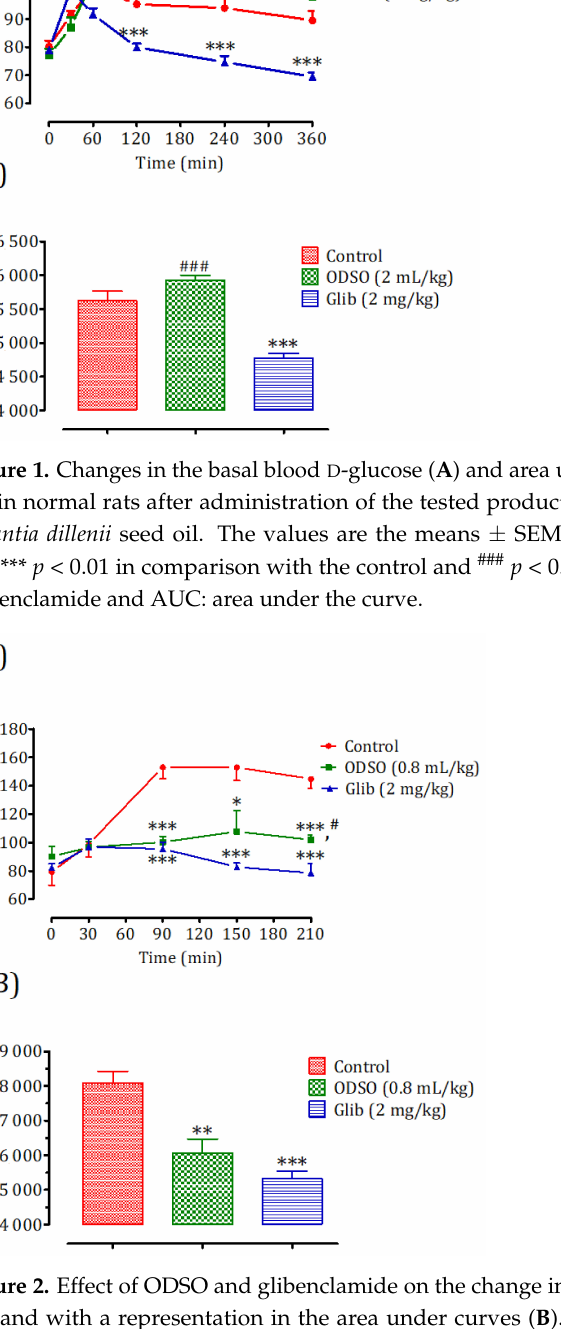
Figure 2. Effect of ODSO and glibenclamide on the change in postprandial glycemia in normal rats ( A ) and with a representation in the area under curves ( B ). ODSO: Opuntia dillenii seed oil. The values are the means ± SEM ( n = 6). * p < 0.05, ** p < 0.01, and *** p < 0.001 compared to the control. # p < 0.05 compared to the glib